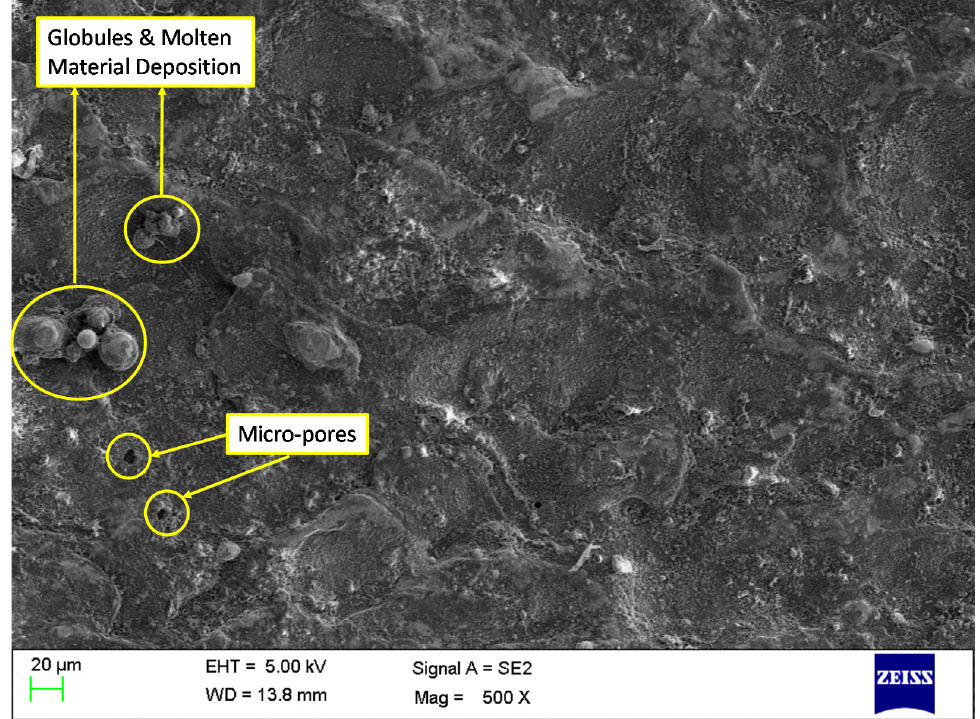
Figure 11. Analysis of machined surface for NPMWEDM (addition of MWCNTs at 1 g/L).